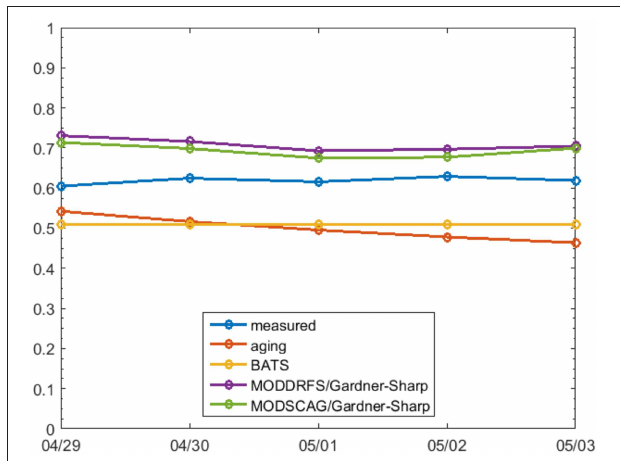
FIGURE 9 | Terrain corrected albedo at CUES in 2011. Measured (terrain corrected) and modeled snow albedo at CUES for four dates during the melt season in 2011. See Section Snow Albedo Case Study for further explanation.